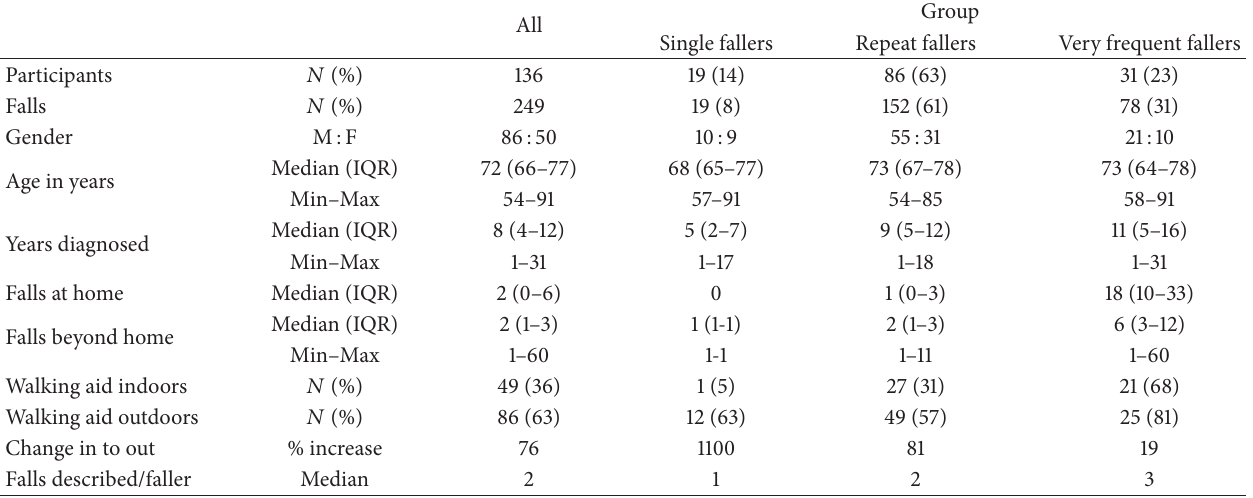
Table 1: Characteristics of participants.